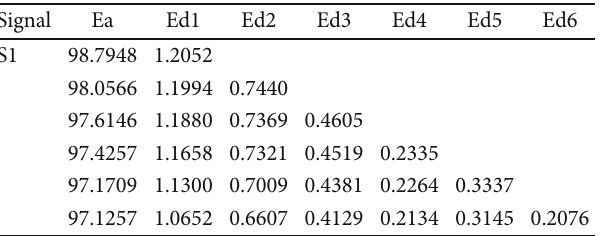
Figure 3: Di ff erentiated decomposed signal after applying DWT shows time-frequency range of (a) standing, (b) FOG, (c) walking, (d) standing, (e) standing, (f) standing, (g) FOG, (h) standing, (i) walking, (j) walking, (k) walking, and (l) FOG. Table 1: Energy distribution computation for the DWT of Table 2: Energy distribution computation for the DWT of frequency range of FOG. frequency range of standing.